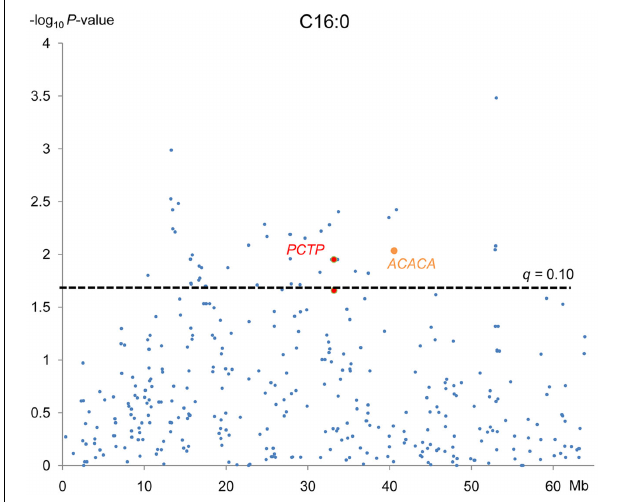
FIGURE 3 |Association analyses between C18:3 ( n − 3) fatty acid and 374 SNPs mapped in SSC12. Each dot represents one SNP. On the y -axis are − log 10 of P -values and on the x -axis, the physical position of the SNP in the SSC12. Cut off value is 1.6 which represents a q = 0.10.